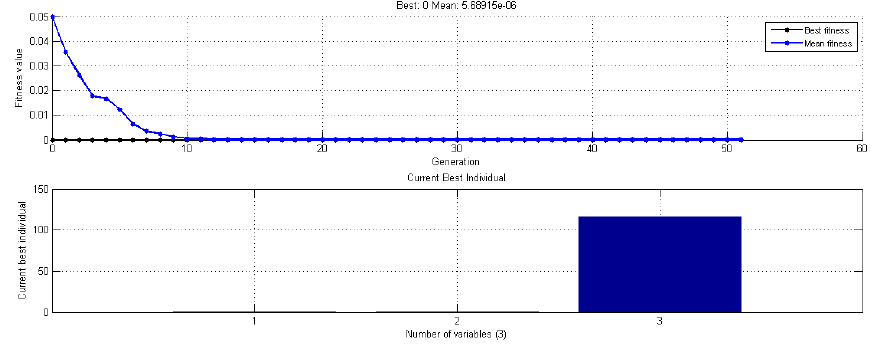
Figure 5. Trend of the dimension convergenze of the working